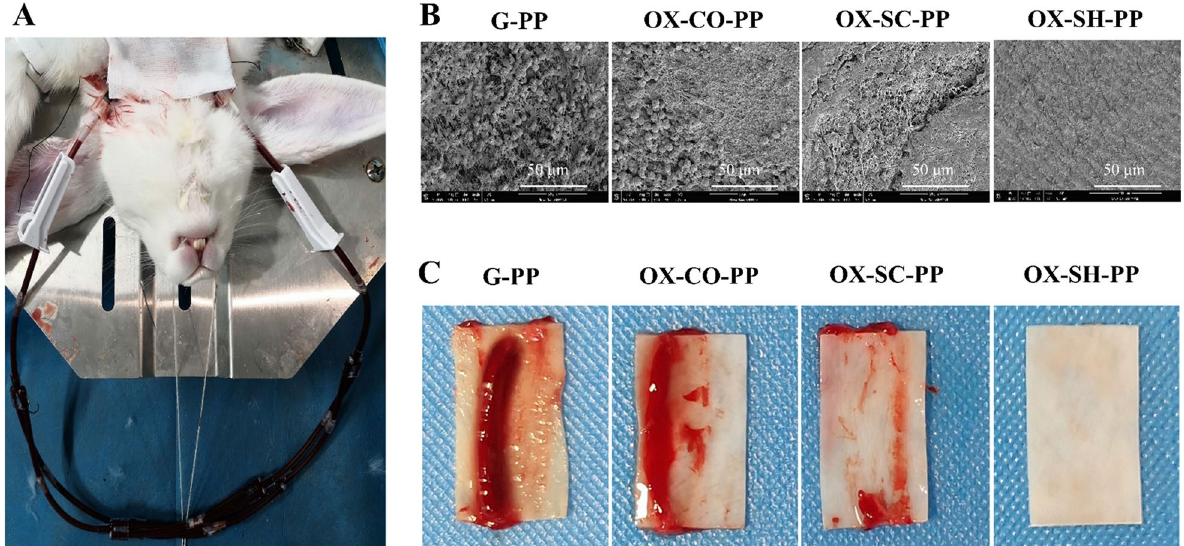
Fig. 4 Evaluation of the hemocompatibility of G-PP, OX-CO-PP, OX-SC-PP and OX-SH-PP by ex vivo AV-shunt in rabbits for 2 h. A Illustration for AV-shunt assay. B SEM images of cross-linked PPs after ex vivo AV-shunt assay. C Images of cross-linked PPs after ex vivo AV-shunt